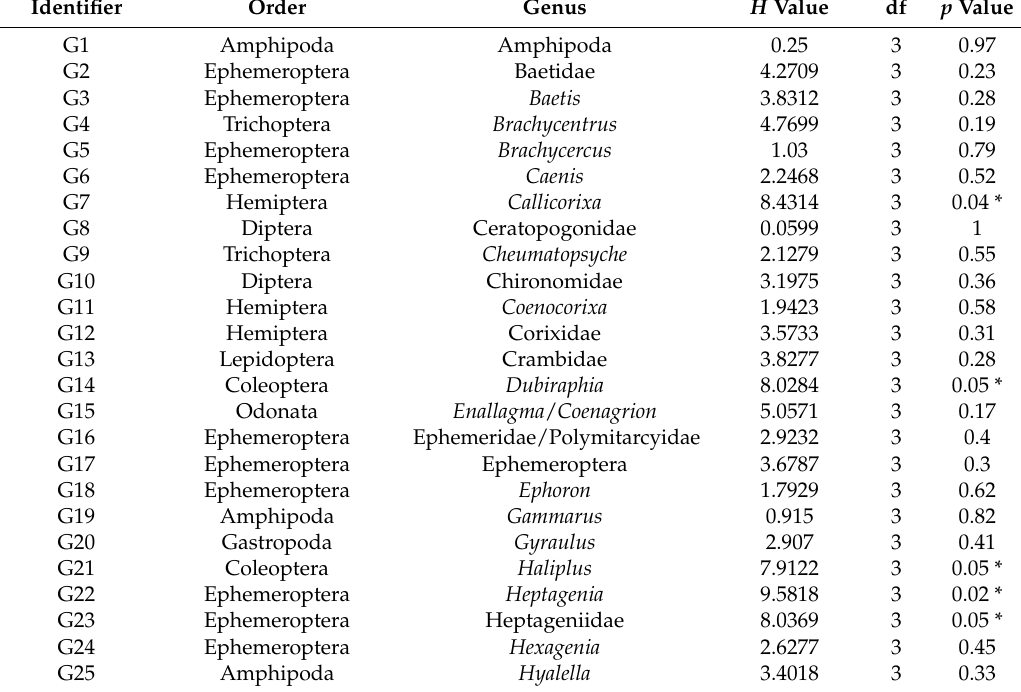
Table 2. Kruskal–Wallis Test results for the 50 common genera, with H values, degrees of freedom (df), and p